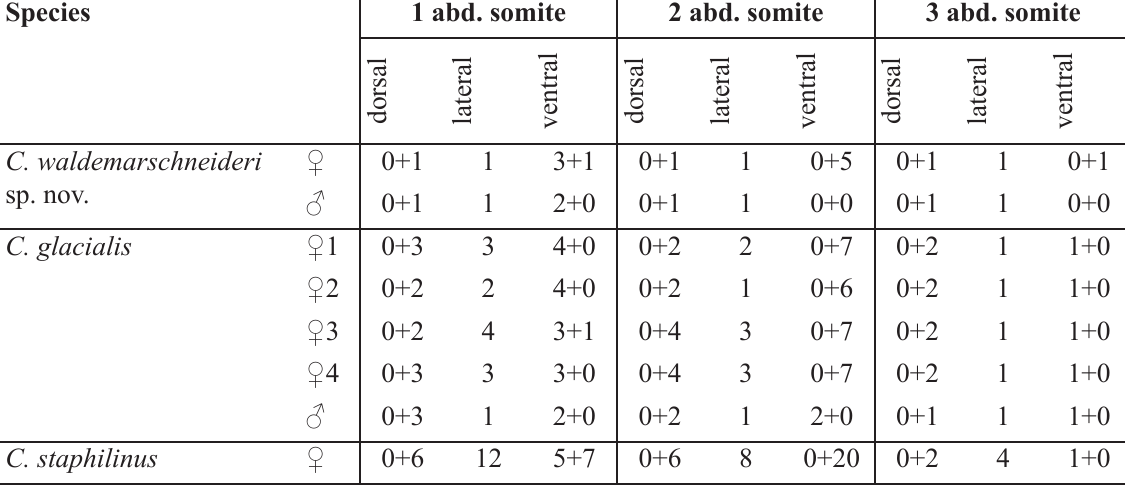
Table 8. Pore composition of the abdominal somites of three species of Canthocamptus Westwood, 1836. Decoding of the entries in the cells: paired pores + unpaired pores. The lateral group is always